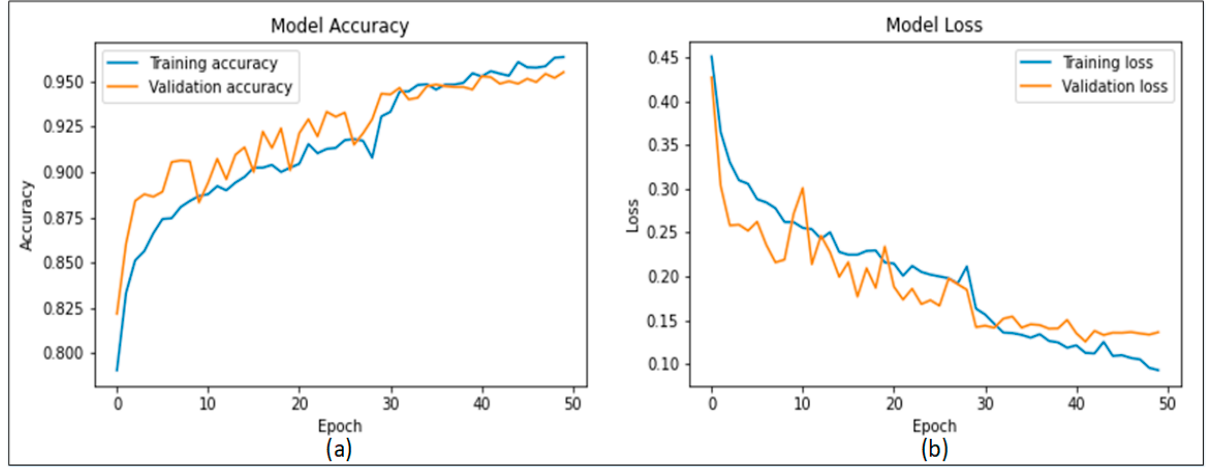
Figure 10. Training plots of Modified DenseNet201 ( a ) Accuracy plot ( b ) Loss plot.